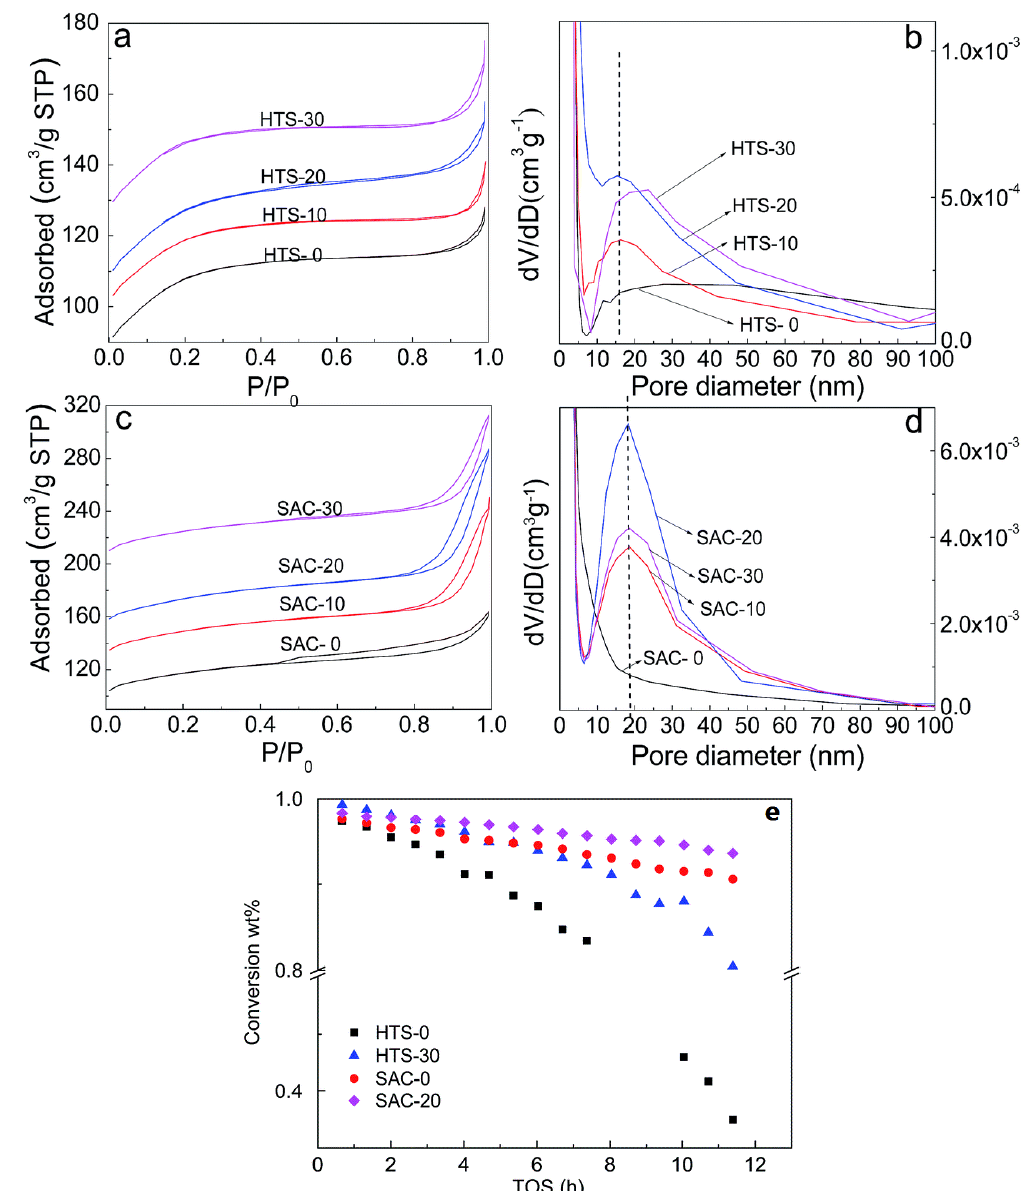
Figure 9. N 2 adsorption–desorption isothermals and pore size distribution of calcined HZSM-5: ( a , b ) HTS method; and ( c , d ) SAC method; and ( e ) conversion of n -decane cracking over HZSM-5 as a function of TOS. HTS-x or SAC-x, “x” denotes the percentage of mass ratio of CNTs to TEOS [71]. Copyright Royal Society of Chemistry, 2015.